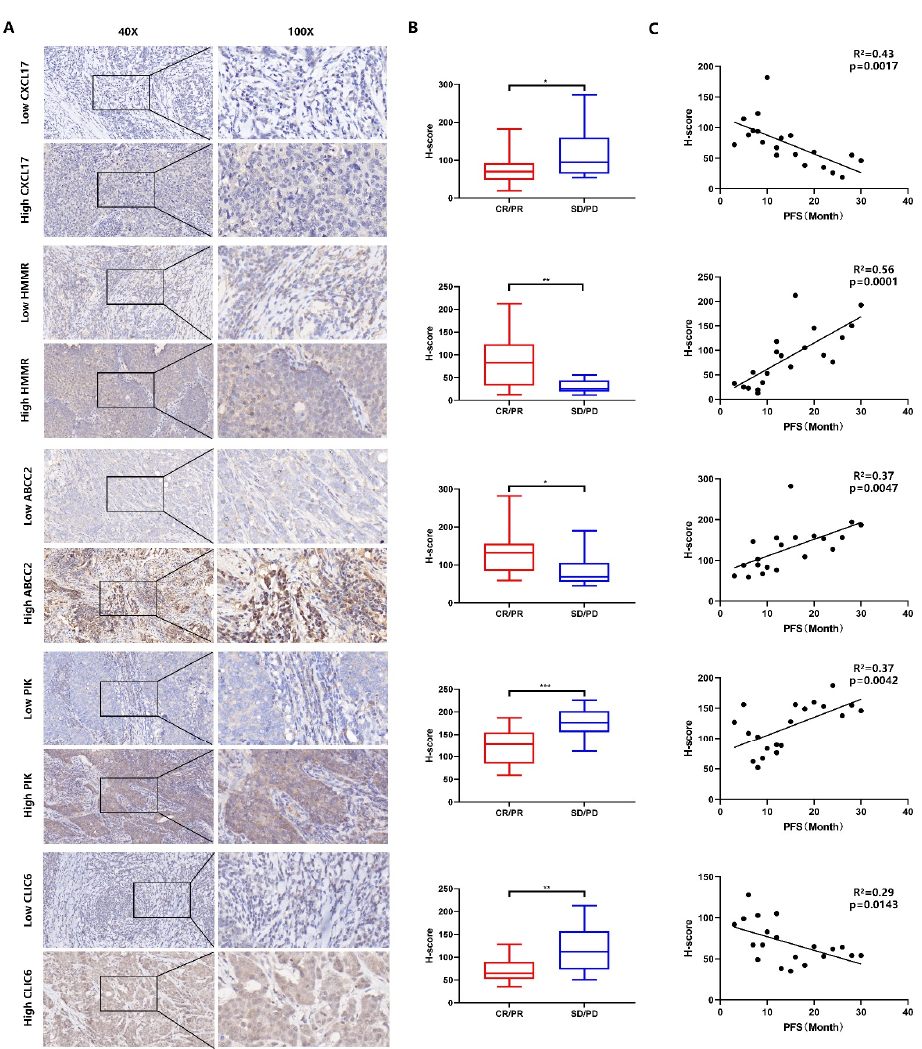
Figure 7. Model genes in the role of anti-PD-1/L1 immunotherapy. ( A ) The expression of HMMR, CLIC6, CXCL17, ABCC2, and PLK1 in patients that received anti-PD-1/PD-L1 immunotherapy was examined by IHC. ( B ) The H-score of five genes in patients who showed CR/PR (n = 20) or SD/PD (n = 10) was compared. ( C ) In CR/PR patients, the correlation of the H-score of five genes and PFS was analyzed by linear regression. * p < 0.05, ** p < 0.01, *** p < 0.001.